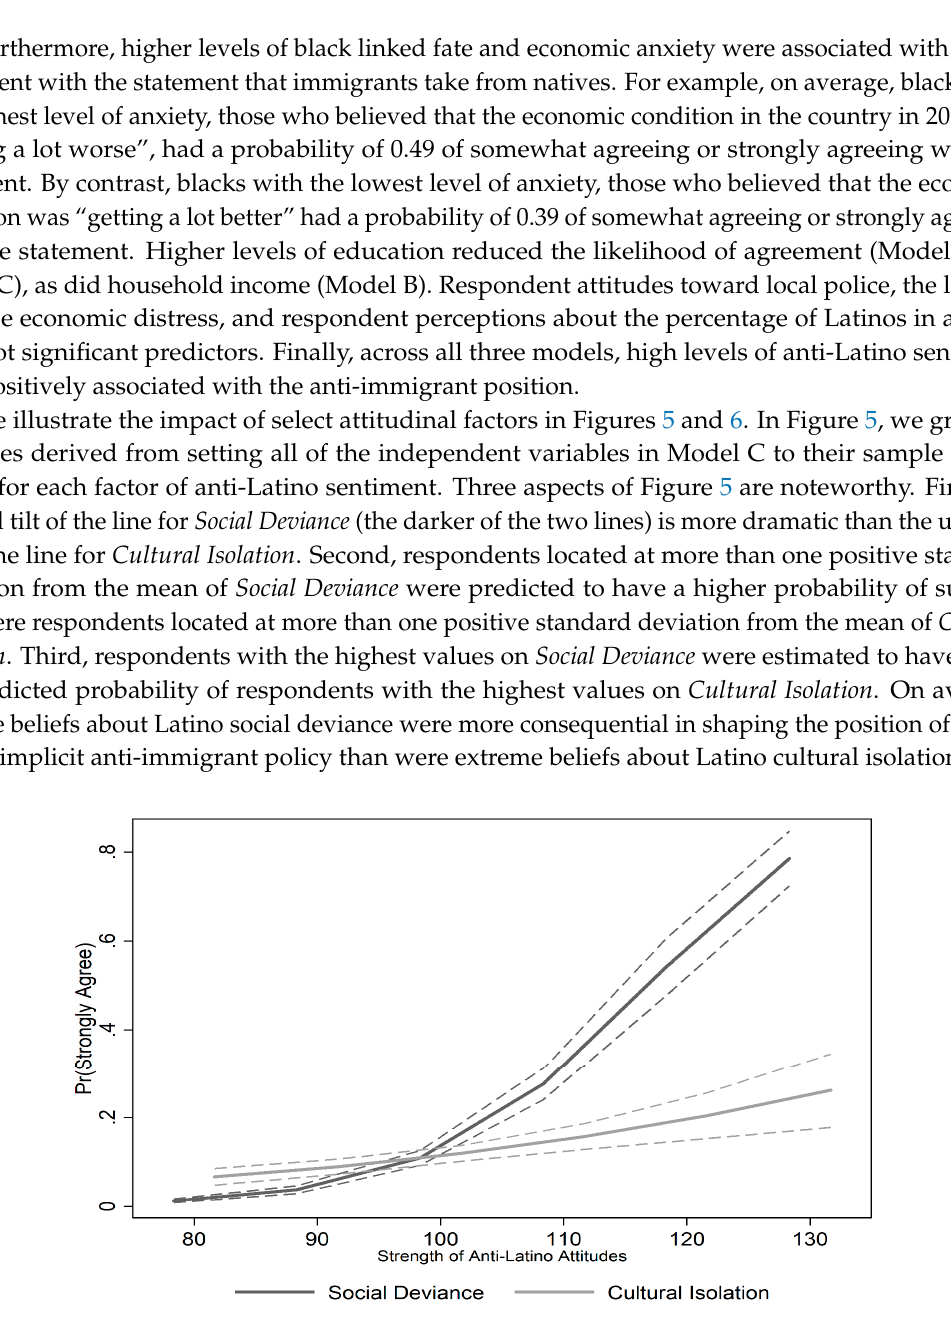
Figure 5. Probabilities for strongly agreeing that immigrants take by anti-Latino attitudes.